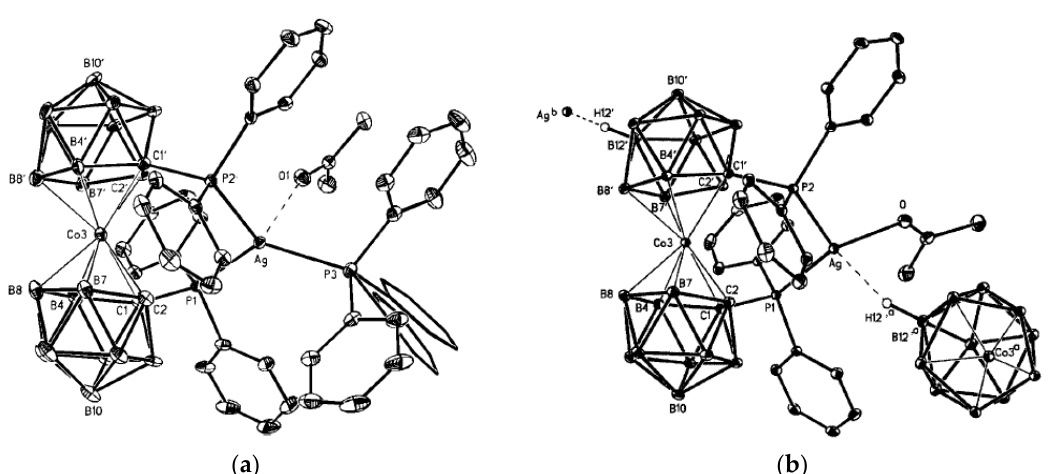
Figure 121. X-ray structures of {(Ph 3 P)Ag[1,1’-(Ph 2 P) 2 -3,3’-Co(1,2-C 2 B 9 H 10 ) 2 ]}·acetone ( a )